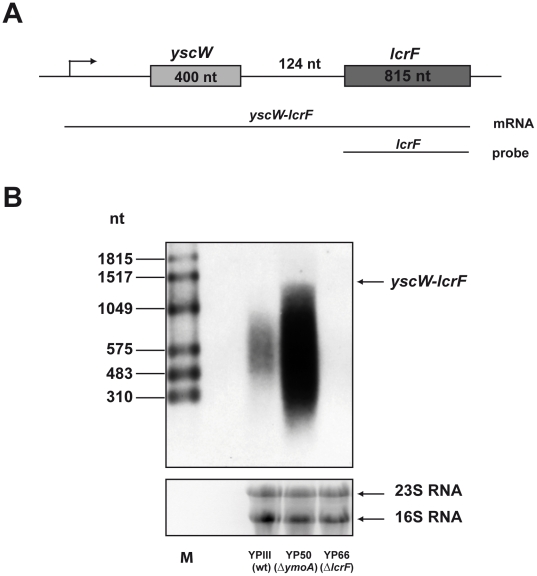
Analysis of the yscW-lcrF mRNA in wildtype and the ymoA mutant strain.(A) Schematic presentation of the yscW-lcrF operon, the yscW-lcrF mRNA and the lcrF probe used for Northern Blot analysis shown below. (B) Total RNA of YPIII, YP50 and YP66 was prepared, separated on a 1.2% agarose gel, transferred onto a Nylon membrane and probed with Digoxigenin-labelled PCR fragment encoding the lcrF gene. The 16S and 23S rRNAs are shown as RNA loading control. A RNA marker is loaded on the left.